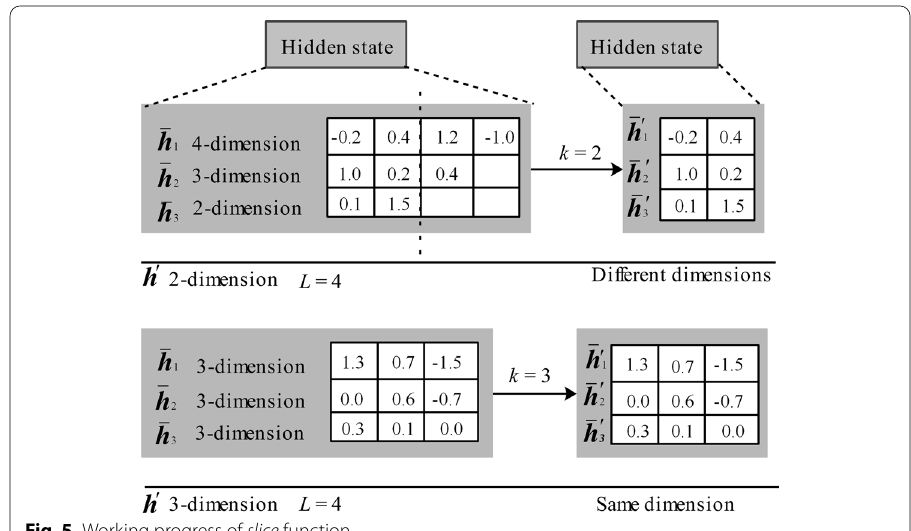
Fig. 5 Working progress of slice